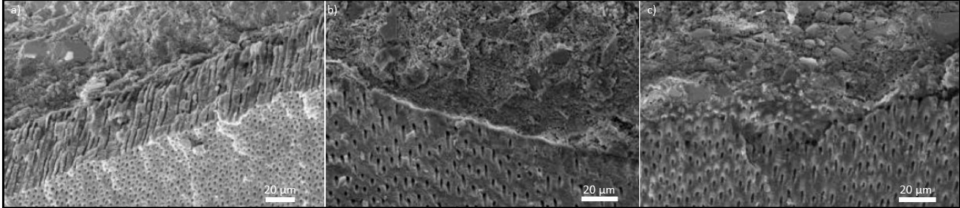
Figure 12. The border of the close connection of resilon with the root canal dentin (SEM): ( a ) visible cross-section of dentinal tubules along their axis, transverse to the axis of the root canal; ( b ) a thin intermediate layer of sealant and dentin tubules are visible on the resilon; ( c ) a thick intermediate layer of sealant and dentin tubules are visible on the resilon.